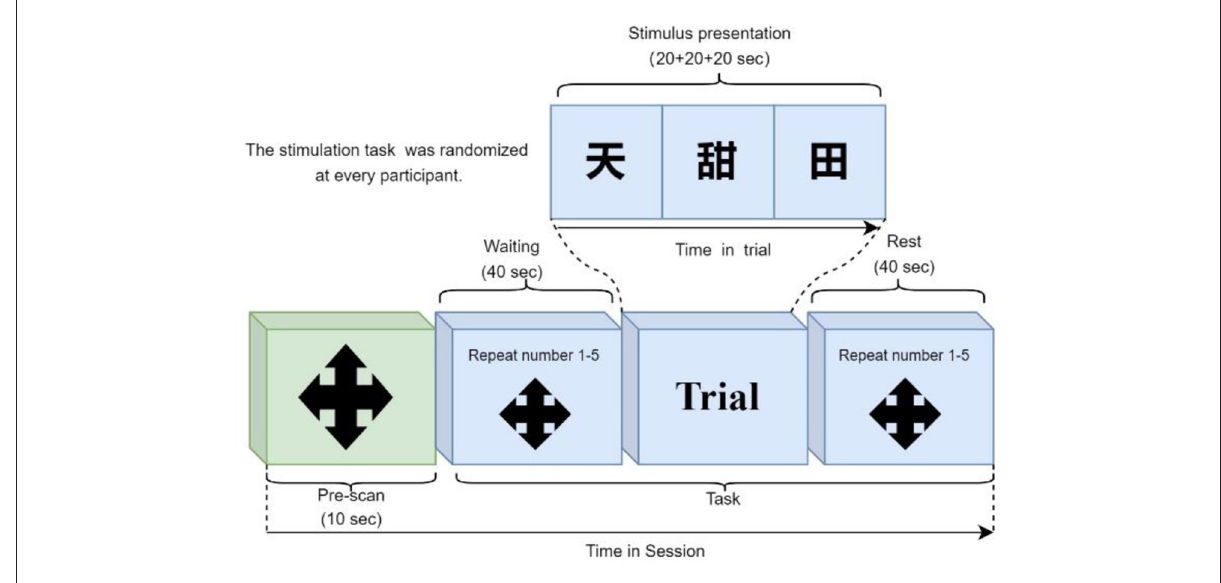
FIGURE1 VFT task-based experiment protocol.